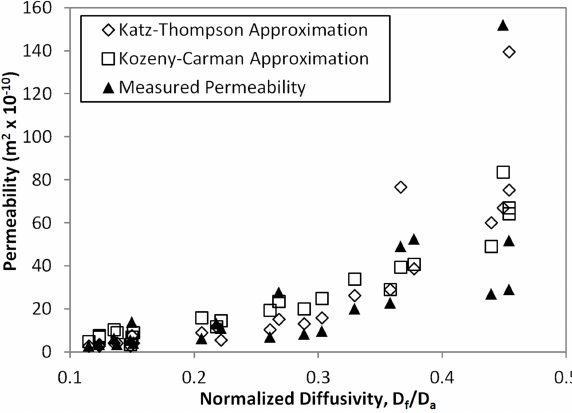
Fig. 5. Measured permeability of Summit, Greenland firn sam- ples compared to Kozeny–Carman and Katz–Thompson approxi- mations.